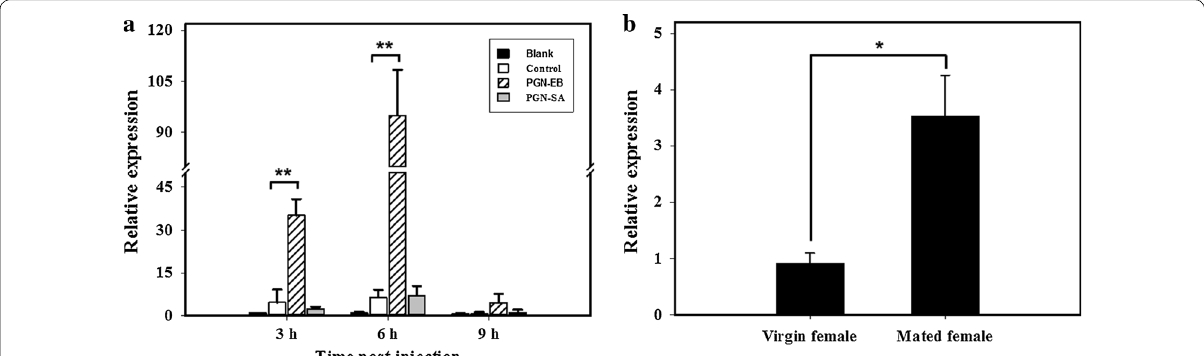
Fig. 5 Effects of PGN challenge and mating on the mRNA expression levels of BdPho in B. dorsalis . a Relative mRNA levels of BdPho after PGN‑EB and PGN‑SA challenge. Blank: without injection; Control: injected with 200 nL sterile endotoxin‑free water; PGN‑EB: injected with 200 nL PGN‑EB solution; PGN‑SA: injected with 200 nL PGN‑SA solution. b Relative mRNA levels of BdPho after mating stimulation. Data represent mean relative level values (mean SE) to reference genes of three independent biological replicates. The two‑tailed, unpaired t ‑test was used to test significance. ± Asterisks indicate significant differences in relative expression (* P < 0.05; ** P <